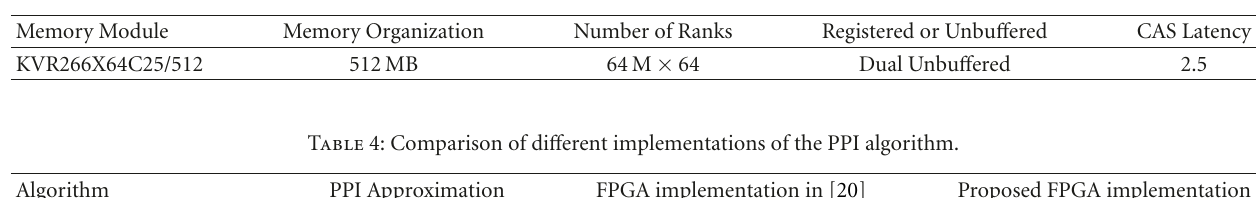
Table 3: Characteristics of the SDRAM memory module used to store the hyperspectral data.